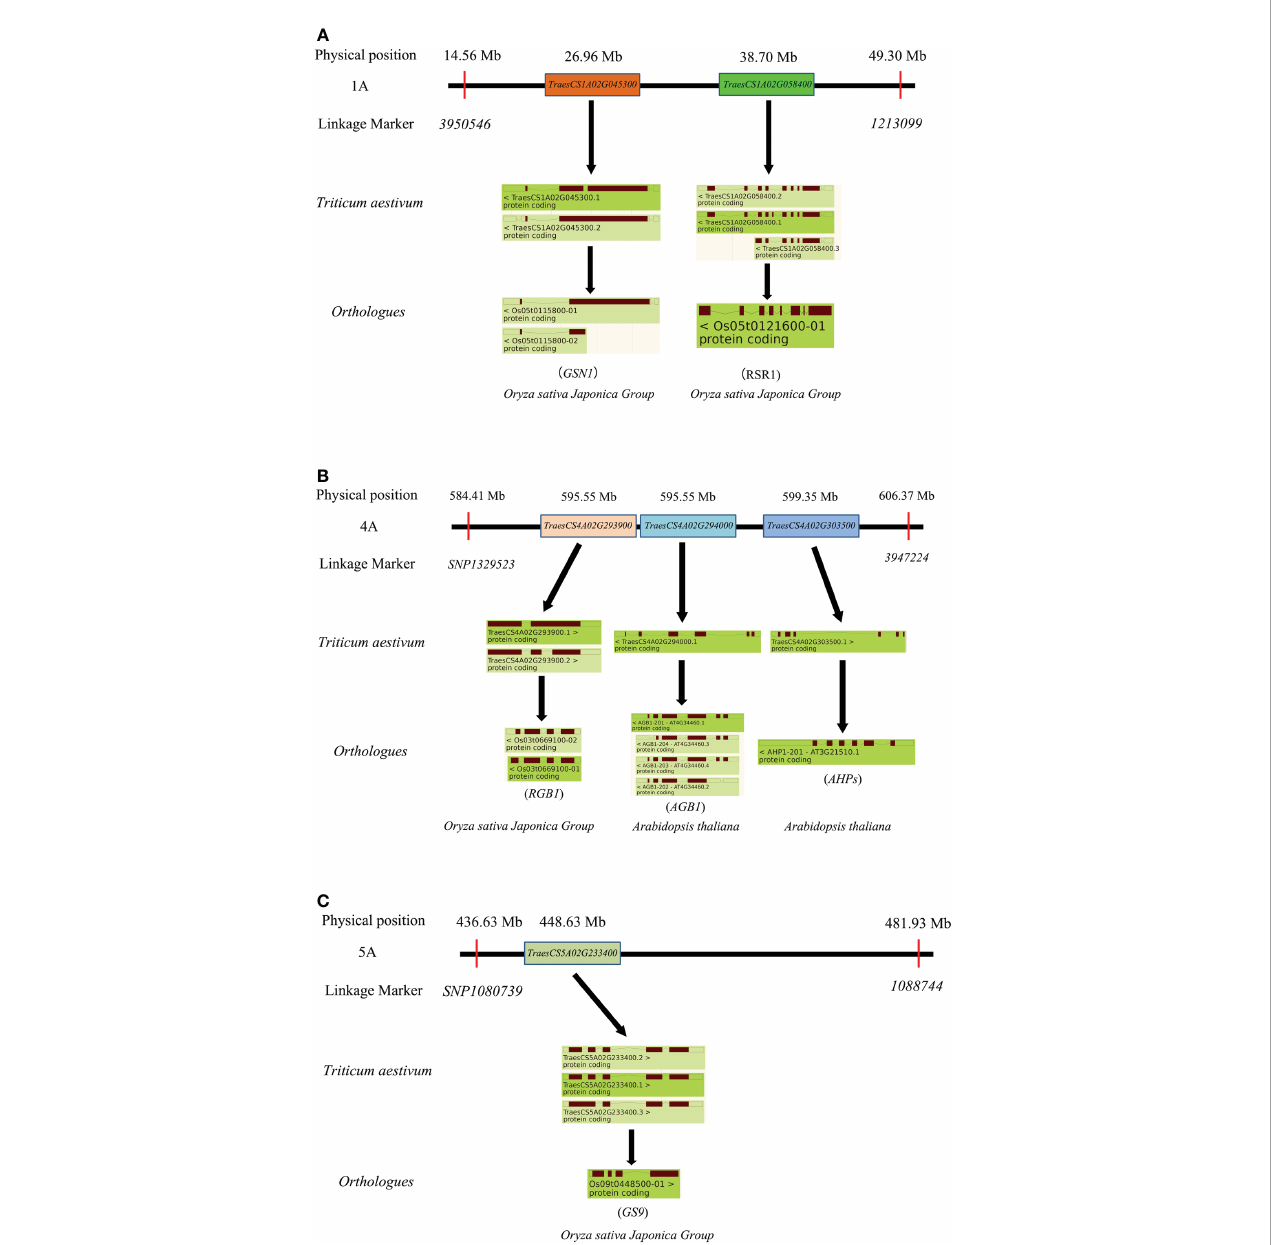
FIGURE 7 Cloned genes affecting kernel traits in candidate intervals. (A) Cloned gene of TaTKW-1A . (B) Cloned gene of TaTKW-4A . (C) Cloned gene of TaTKW-5A